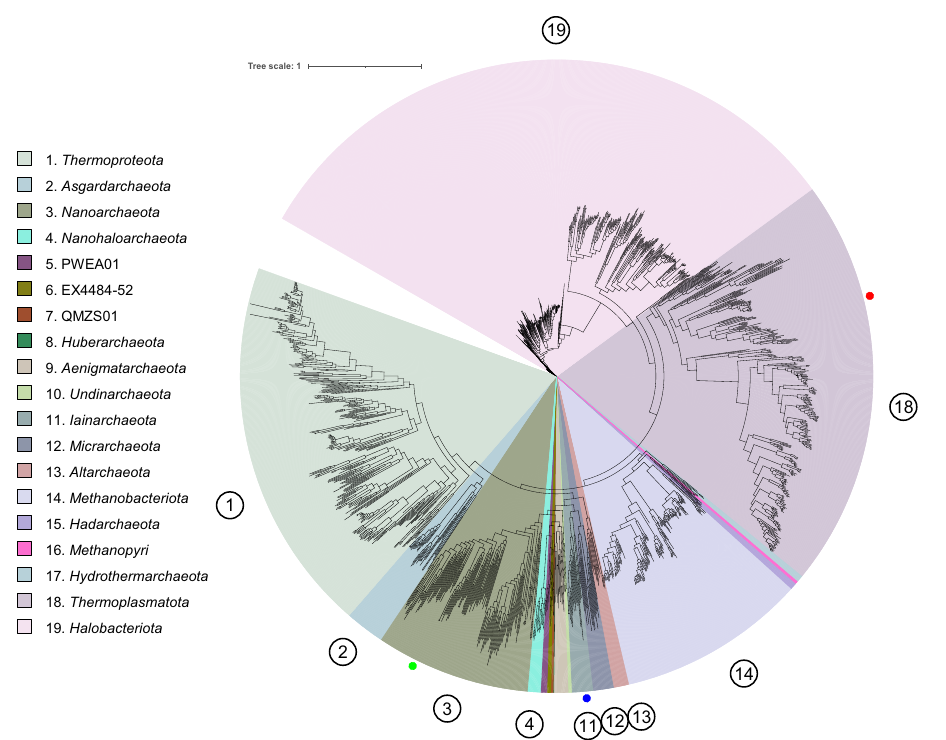
Fig. 3 Molecular phylogenetic analysis of recovered archaeal MAGs. The phylogenetic tree was reconstructed based on the concatenation of 122 single- copy gene protein sequences. After masking, 5124 amino acid sites were used in the analysis. The phylogenetic tree including three MAGs from Lake Shunet and 1672 archaeal representative genomes in GTDB-r95. The blue dot represents the placement of MAG M55A2, the red dot represents MAG M55A1, and the green dot represents MAG M55A3. The numbers in the circle are phyla in the legend. Scale bar represents changes per amino acid